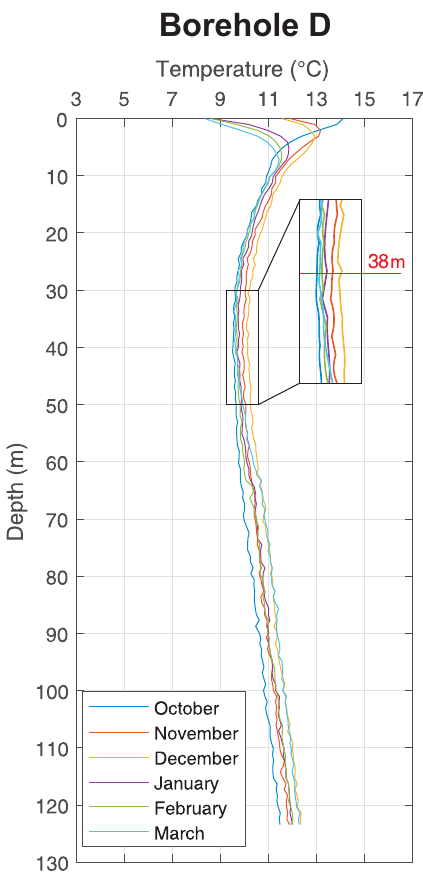
Figure 12. Neutral zone in the depth of approx. 38